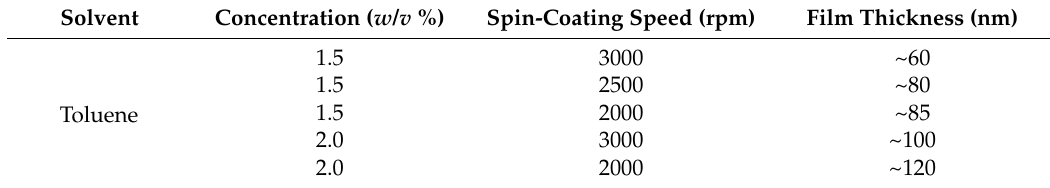
Table 1. Spin-coating conditions for various PS- b -P2VP films with different thicknesses.